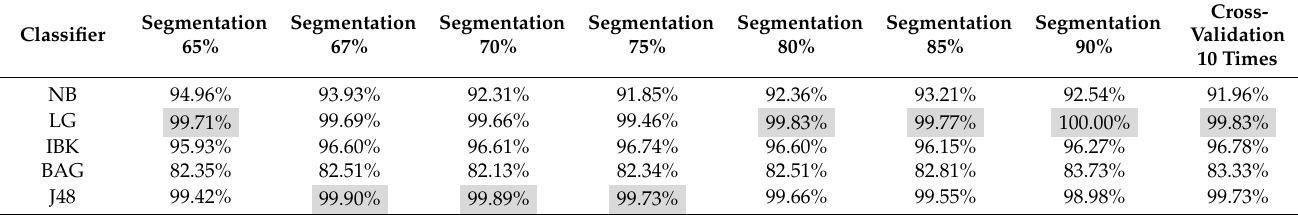
Table 13. The classifier accuracy of no-feature selection for 2455 normal and 491 bankrupt companies (5:1).